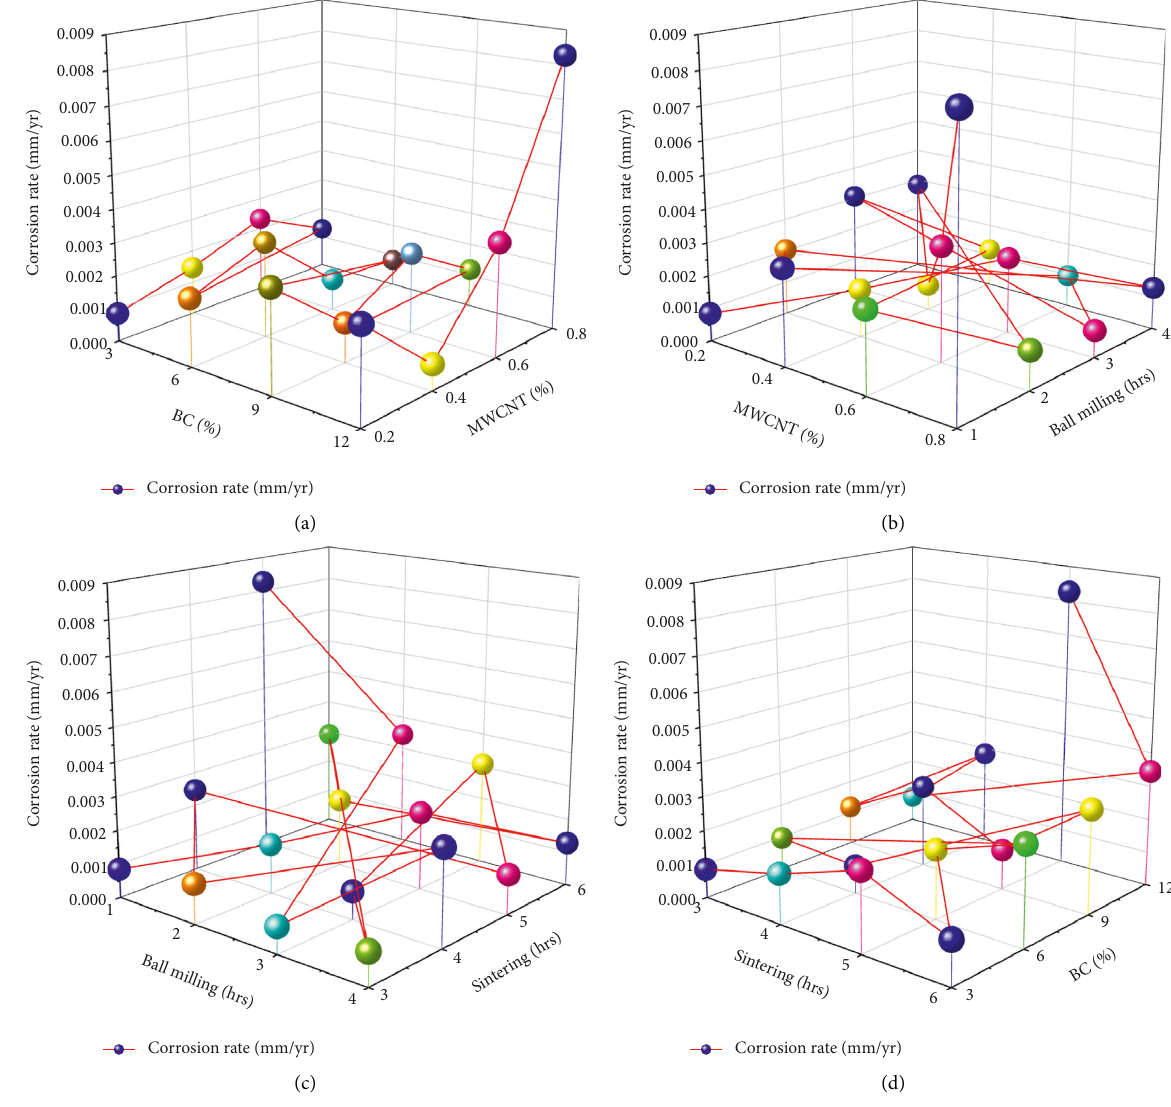
Figure 14: 3D trajectory plot for corrosion rate: (a) B 4 C % vs MWCNT (%); (b) MWCNT (%) vs. ball milling; (c) ball milling vs. sintering; (d) sintering vs. B 4 C